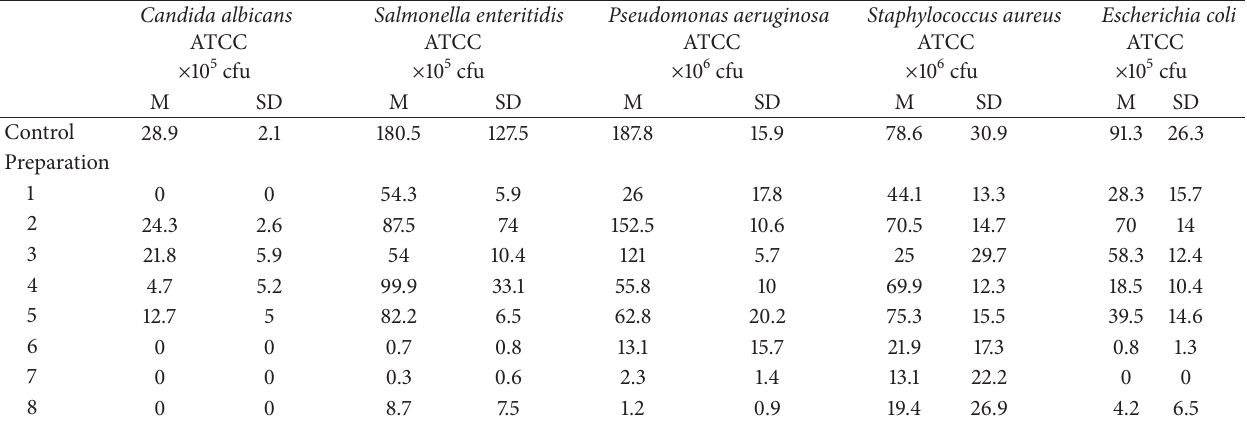
Table 4: The number of bacterial and fungal cells grown after five minutes of contact with nanosilver compared to the control group. Candida albicans